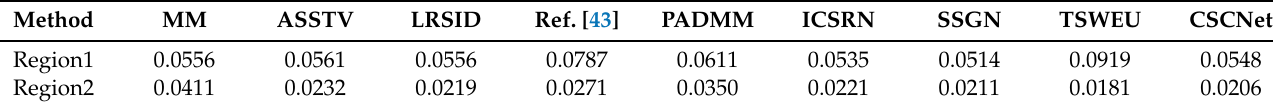
Figure 14. Two ground target regions in the SWIR image. Table 5. Image non-uniformity using nine